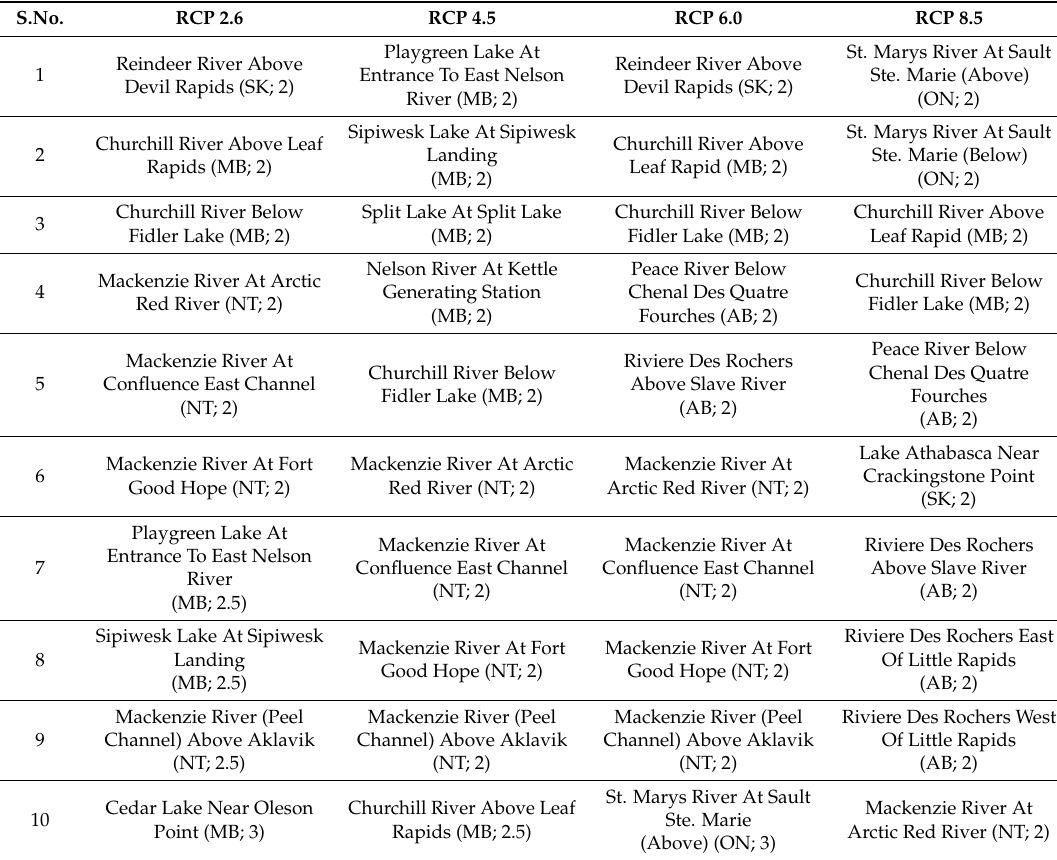
Table 7. List of 10 FRIs projected with largest increases in flooding frequencies for historical 100-year return period flooding events from robust GCM median approach. Information on the province and projected future flood frequency magnitudes in years is also provided within